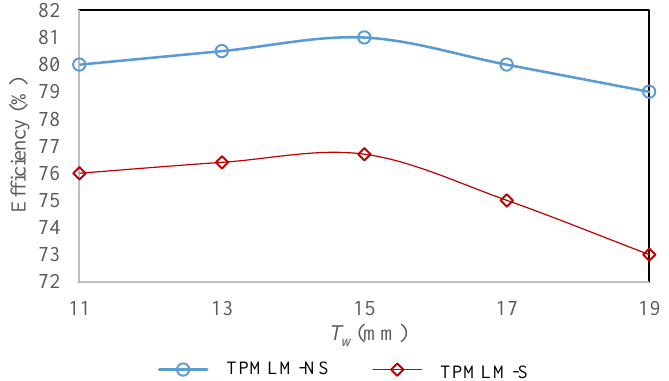
Figure 24. Influences of T w Variation on Efficiency.